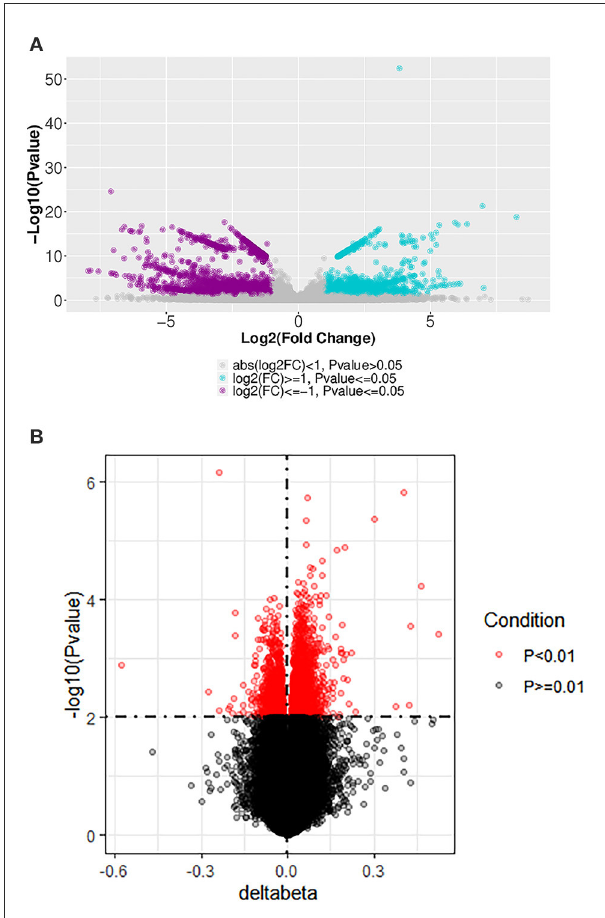
FIGURE1 Volcano plot of differentially expressed mRNA and DNA methylation positions in first-episode, drug-naive adolescents with MDD. (A) mRNAs differentially expressed between first-episode, drug-naive adolescents with MDD and healthy controls. Blue and purple points indicate genes that were up- or down-regulated, respectively, more than two-fold in patients. (B) DNA methylation positions differentially expressed between first-episode, drug-naive adolescents with MDD and healthy